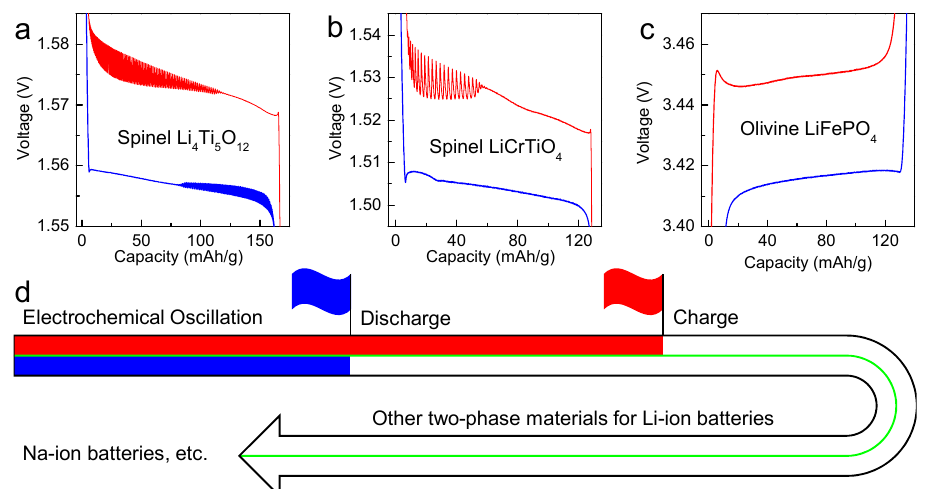
Figure 10. The galvanostatic discharge/charge curves of different electrode materials in Li-ion bat- teries: ( a ) Li 4 Ti 5 O 12 prepared by carbothermic method; ( b ) LiCrTiO 4 prepared by high-temperature solid-state method, and ( c ) commercial LiFePO 4 , ( d ) the research progress in electrochemical oscilla- tion of Li-ion